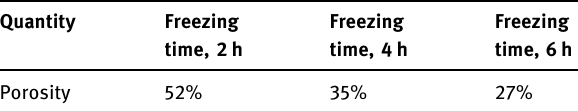
Table 1: Porosity sca ff old with various freezing time Quantity